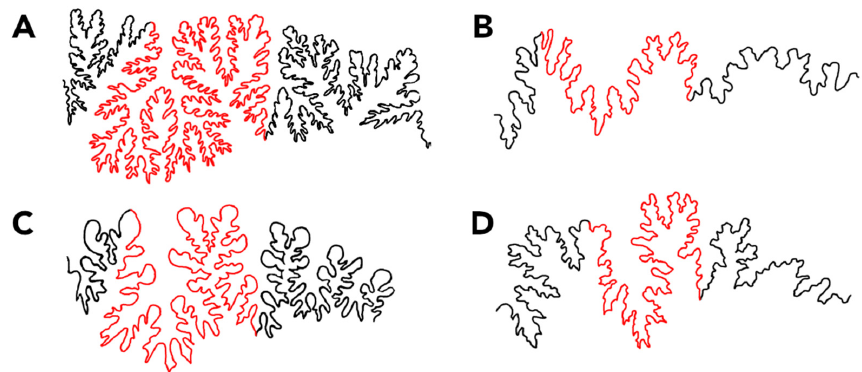
Figure 2. LLS portion of suture with cutoff points determined by Marriott and Chamberlain [1] highlighted in red, with L max values representing the distance between the lateral lobe (L) and sec- ond saddle (S 2 ) for ( A ) Lytoceras (retracted from [22]) ( B ) Cadoceras (retraced from [23]) ( C ) Phylloceras (retraced from [24], and ( D ) Perisphinctes (retraced from [4]).